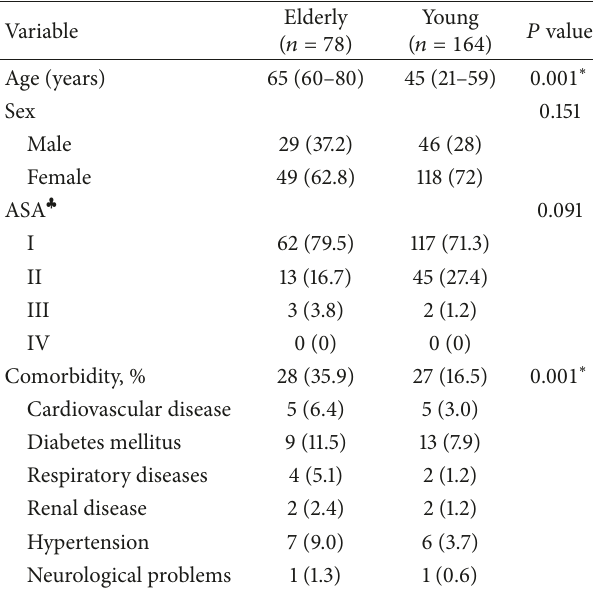
Table 1: Preoperative data.